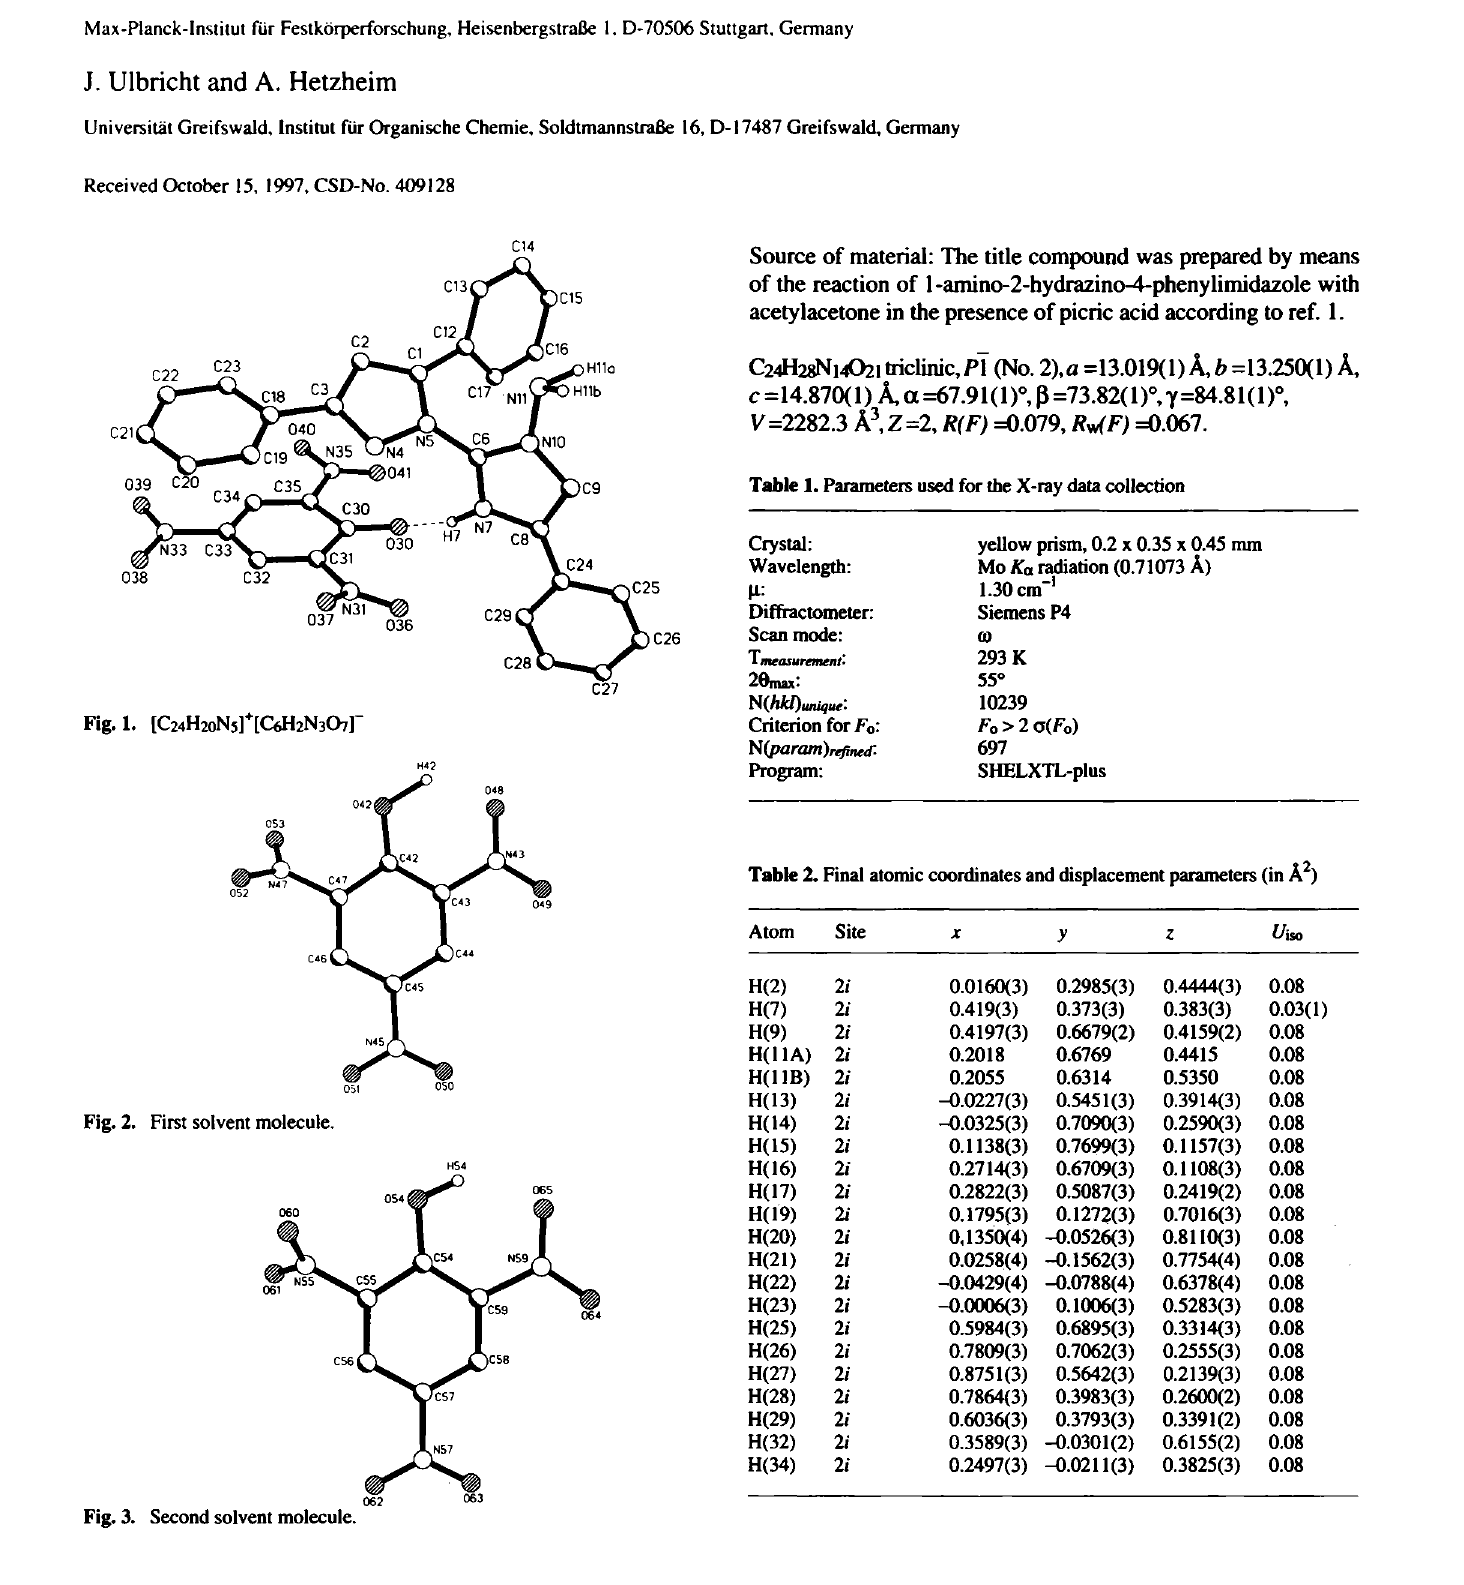
Source of material: The title compound was prepared by means of the reaction of l-amino-2-hydrazino-4-phenylimidazole with acetylacetone in the presence of picric acid according to ref. 1.